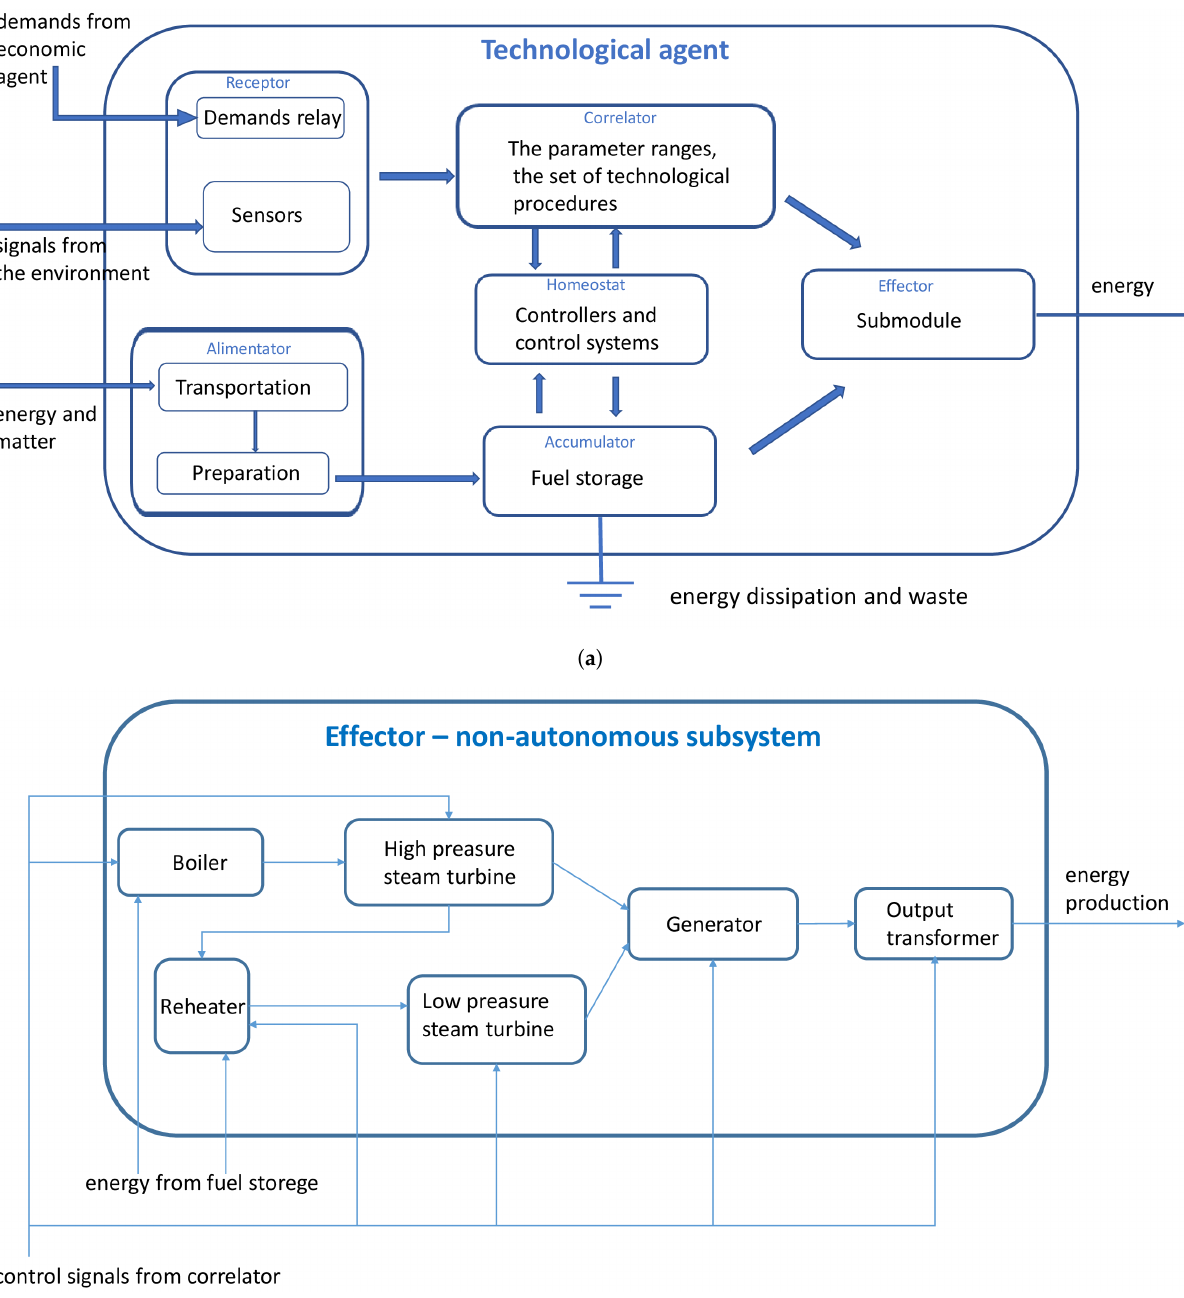
Figure 3. The thermal power plant—the technological agent in the framework of Mazur’s theory. ( a ) The organization of the technological agent in the framework of Mazur’s theory. ( b ) The effector as a non-autonomous subsystem of the technological